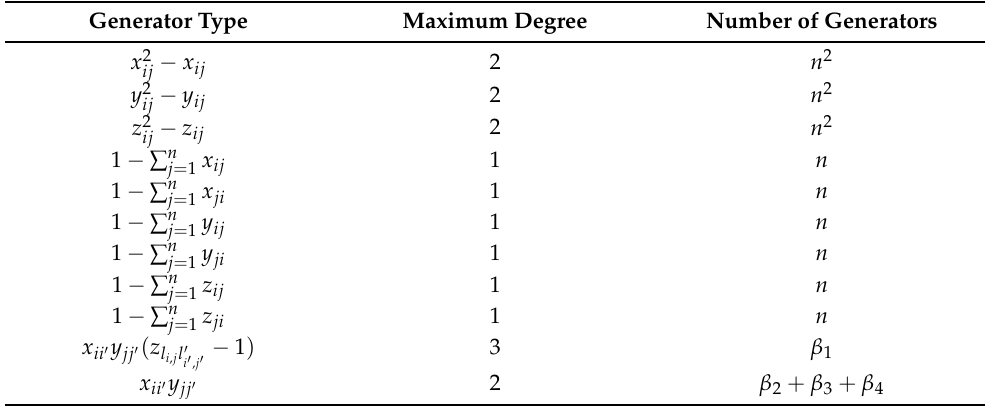
Table 4. Study of the generators of the ideal I PI ( L 1 , L 2 )